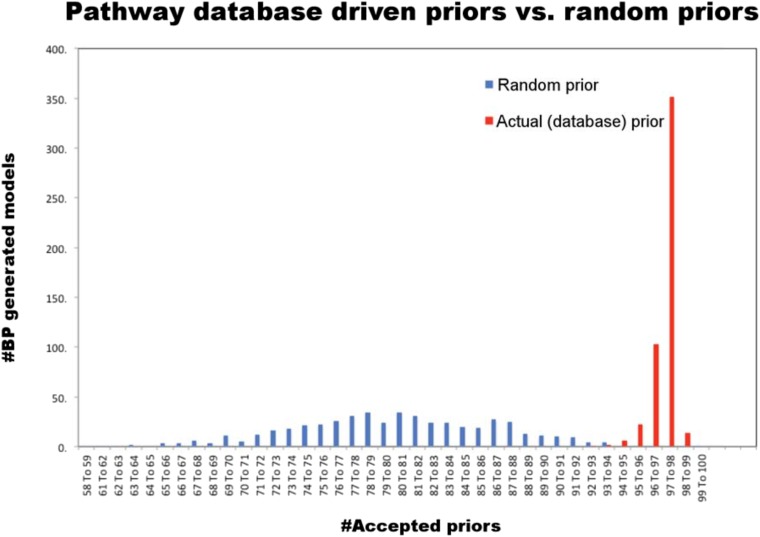
Comparison of random and actual prior information.We tested whether the database driven prior model conforms to the experimental data and prior information does not overly restrain the inferred models. For this purpose, we constructed and compared network models using the pathway driven and randomly generated prior restraints in BP-based modeling. We have tested 500 unique, randomly generated pseudoprior restraints each containing 154 interactions, equal to the number of interactions in the pathway driven prior model. The models are generated using a fast BP-based inference method, which is different than the BP-based decimation. For model construction, we first computed the probability distribution of edge values (P(Wij)) for each possible interaction. Next, we constructed the models by assigning the edge value (Wij) for which BP-generated P(Wij) is maximum. We compared the models generated with different prior models for their prior scores (i.e., number of edges, which were both accepted by the algorithm and included in the prior model). The models generated using the database driven priors had significantly higher accepted priors compared to the randomly generated models (p < 0.05 Student's t-test for H0: μpsrandom = μpsdatabase-driven). Note that, we performed 500 parallel BP runs using identical, database driven prior models. We observed a low degree of variation in the number of accepted priors when the models are generated using the database driven priors. This is indicative of some solution degeneracy in the models. In predictive network modeling, we accounted for the solution degeneracy by re-computing the P(Wij) at the initial step of each BP-guided decimation calculation.